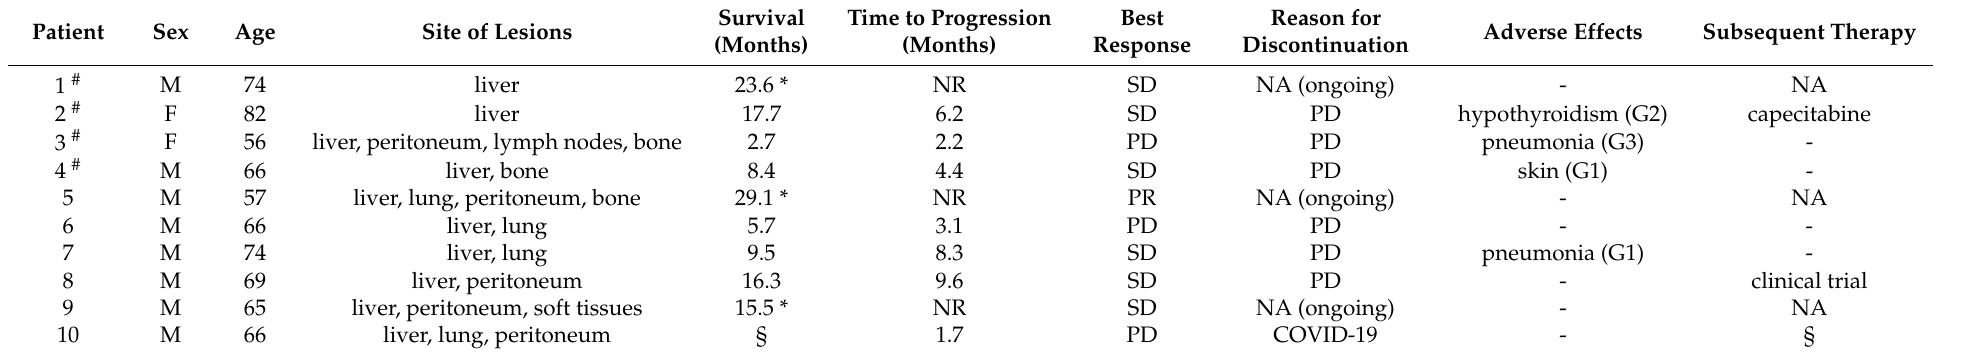
Table 2. Treatment